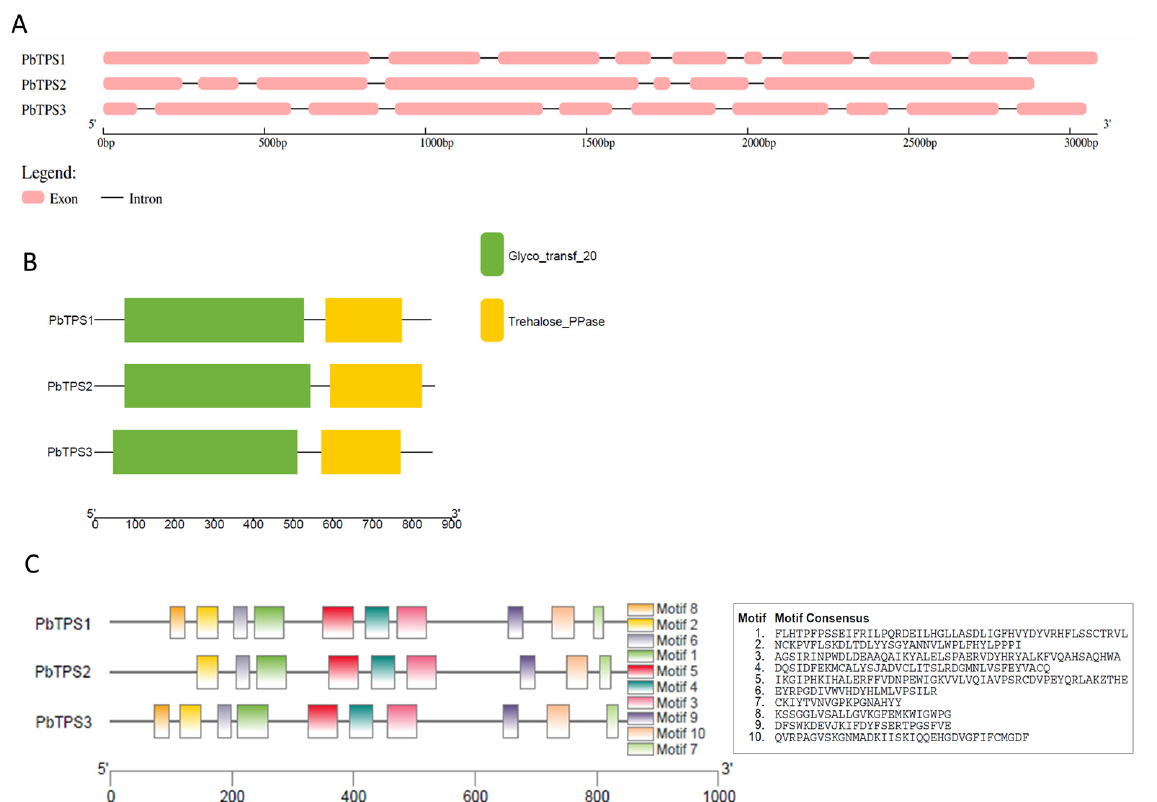
Figure 4. Gene structures, domains, and motifs of the PbTPS family. ( A ) Exon/intron organization of PbTPS genes. Pink boxes represent exons and black lines with same length represent introns. The length of exons can be inferred by the scale at the bottom. ( B ) The conserved domain analysis of PbTPS protein. Trehalose-6-phosphate synthase (TPS) domain (Glyco_transf_20), trehalose-6-phosphate phosphatase (TPP) domain (Trehalose_PPase) are shown by green and yellow, respectively. ( C ) Conserved motifs of PbTPS. Ten putative motifs are indicated in different colored boxes. The details of the motifs are listed on the right.